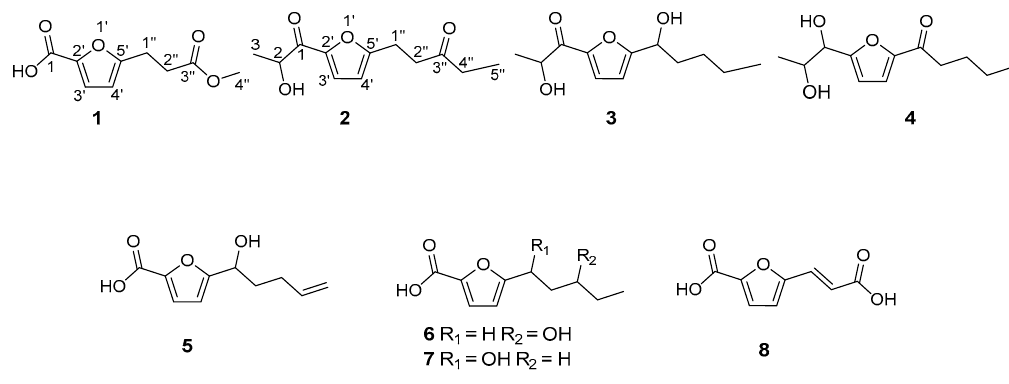
Figure 1. Structures of compounds 1 – 8 .